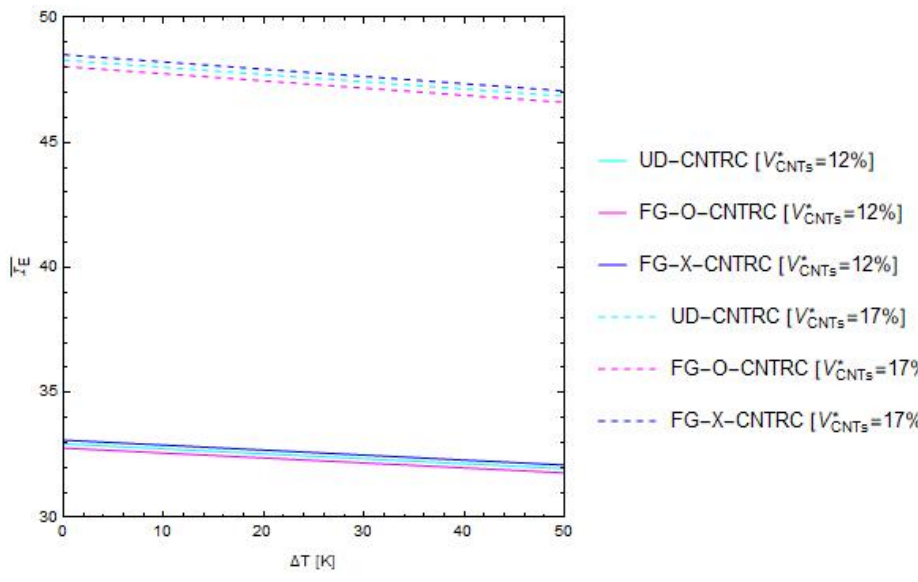
Figure 3. Influence of the uniform temperature rise, ∆𝑇 , on the non-dimensional bending stiffness, (cid:3365) , varying the total volume fraction and the distribution schemes of the CNTs. I 𝐼 E , varying the total volume fraction and the distribution schemes of the (cid:3006)